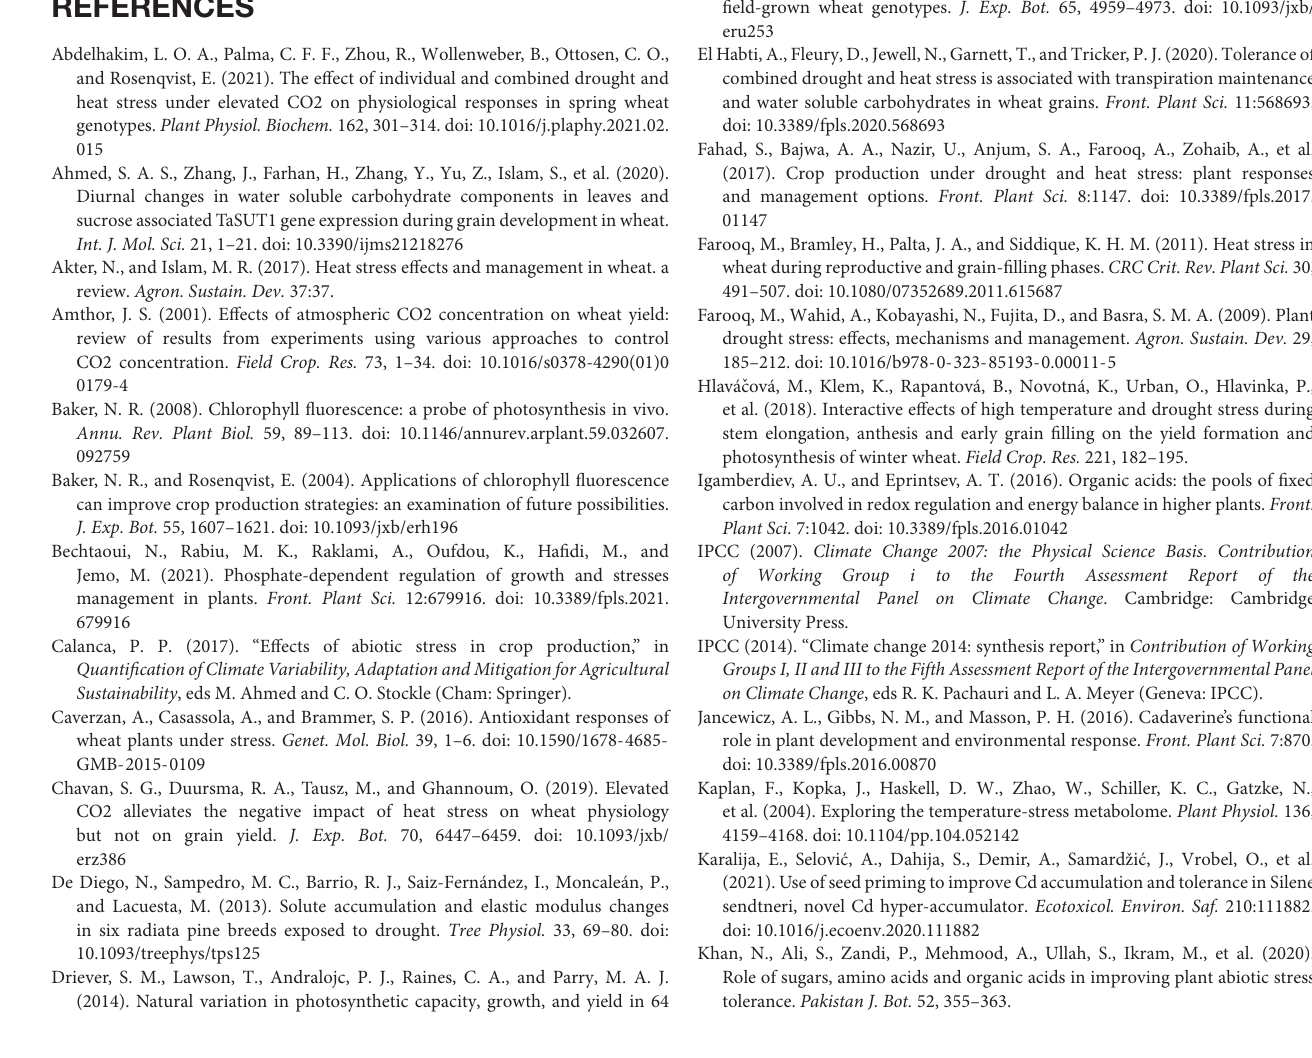
Supplementary Figure 1 | Light response curves. (A) Net photosynthetic rate (P n ), (B) intercellular CO 2 (C i ), (C) stomatal conductance (g s ), (D) transpiration rate (E) and (E) difference between leaf and air cuvette temperature ( (cid:49) T) in heat-sensitive (SF29) and heat-tolerant (LM20) genotypes grown under control conditions (C), heat stress at Day 4 (H4), at Day 7 (H7), and combined heat stress and drought at Day 7 (D + H7) at ambient CO 2 (aCO 2 ) indicated as dashed lines or elevated CO 2 (eCO 2 ) indicated as solid lines. The data represent mean values ± standard error (S.E.) ( n = 6–8). Supplementary Figure 2 | Chlorophyll fluorescence parameters from light response curves. (A) Operating efficiency of PSII (F q (cid:48) /F m (cid:48) ) and (B) electron transport rate (ETR) in heat-sensitive (SF29) and heat-tolerant (LM20) genotypes grown under control conditions (C), heat stress at Day 4 (H4), at Day 7 (H7), and combined heat stress and drought at Day 7 (D + H7) at ambient CO 2 (aCO 2 ) indicated as dashed lines or elevated CO 2 (eCO 2 ) indicated as solid lines. The data represent mean values ± standard error (S.E.) ( n = 6–8). Supplementary Figure 3 | The water status in plants. (A) Instantaneous water use efficiency (WUE leaf ), and (B) leaf relative water content (LRWC) in heat-sensitive (SF29) and heat-tolerant (LM20) genotypes grown under control conditions (C), heat stress at Day 4 (H4), at Day 7 (H7), and combined heat stress and drought at day 7 (D + H7) at ambient CO 2 (aCO 2 ) or elevated CO 2 (eCO 2 ). The data represent mean values ± standard error (S.E.) ( n = 6–8). Different small